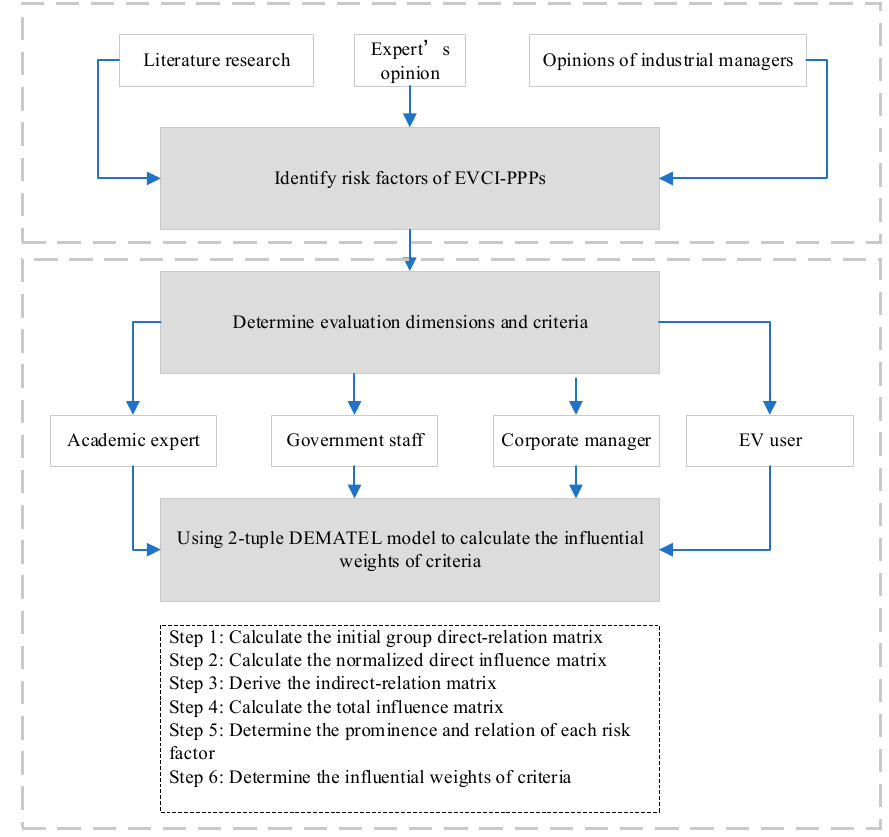
Figure 3. The procedure of the risk analysis model based on 2-tuple decision-making trial and evaluation laboratory (DEMATEL).